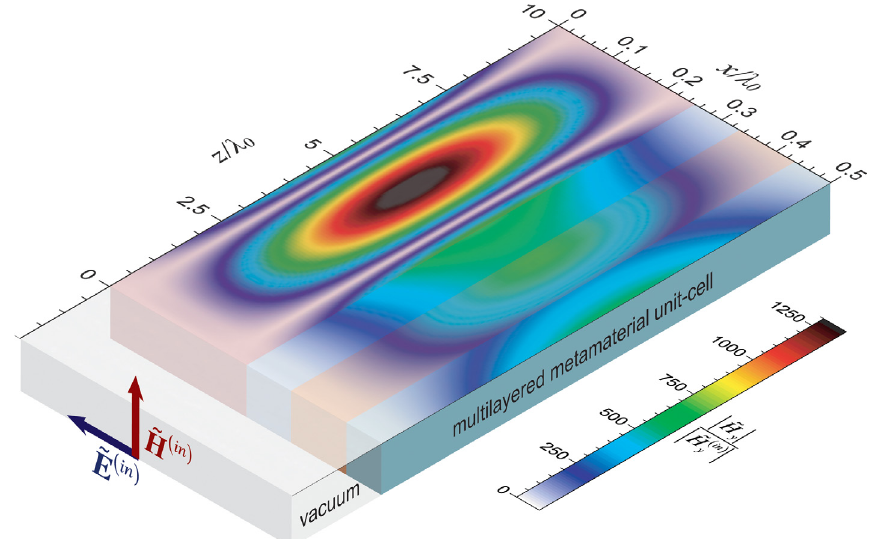
Figure 5. Finite-element-computed magnetic-field map, at the design angular frequency x 0 , over a unit cell of the synthesized multilayered metamaterial (with parameters as in Figure 2 caption). A half-space configuration is assumed, with plane-wave excitation normally impinging from vacuum. The false-color-scale map indicates the field magnitude normalized with respect to the incident one. The field map is superimposed on the unit-cell (shown in trasparency).